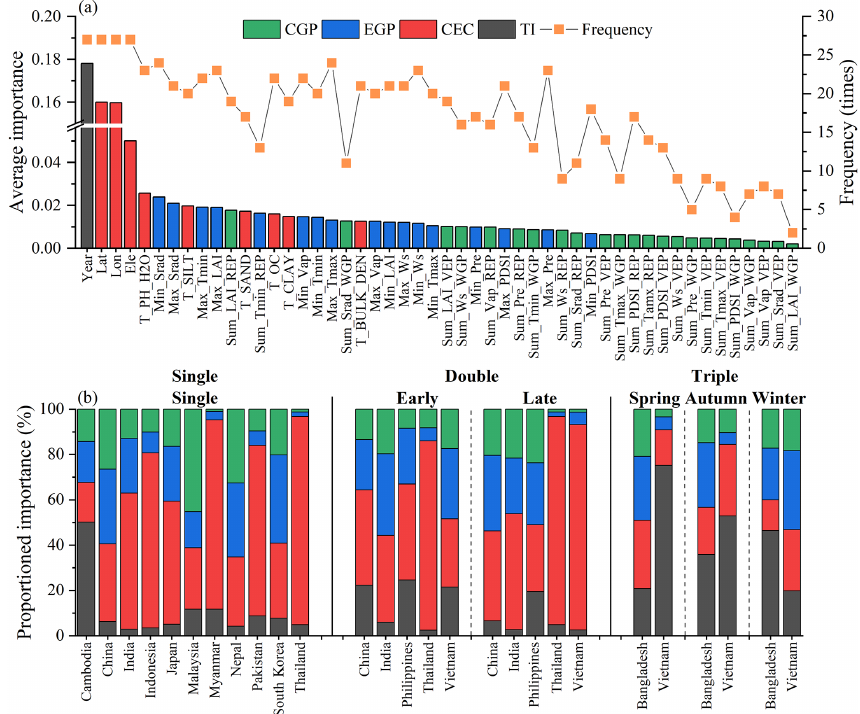
Figure 9. Panel (a) shows the average frequency and importance of each predictor, and panel (b) presents the proportioned importance of each predictor category for seasonal